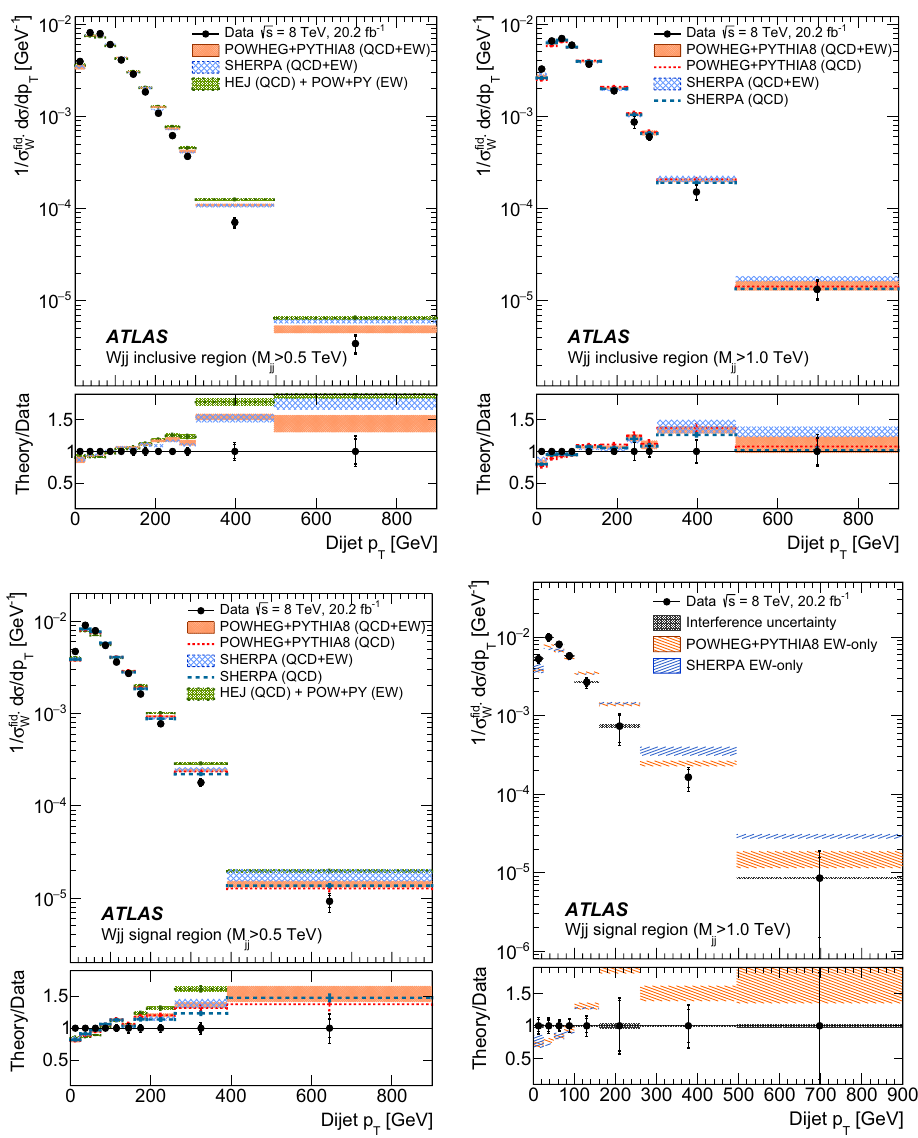
Fig. 26 Unfolded normalized differential W jj production cross sec- tions as a function of dijet p T for the inclusive ( top ) and signal ( bottom ) regions with M jj > 0 . 5 TeV ( left ) and M jj > 1 . 0 TeV ( right ). The bottom right distribution shows EW W jj production and the other dis-